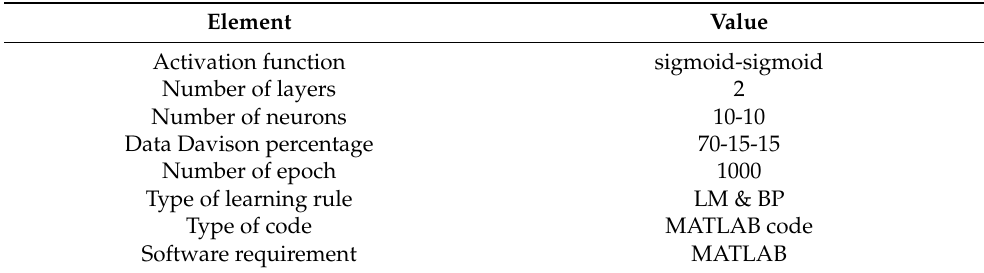
Table 2. Characteristics of the selected